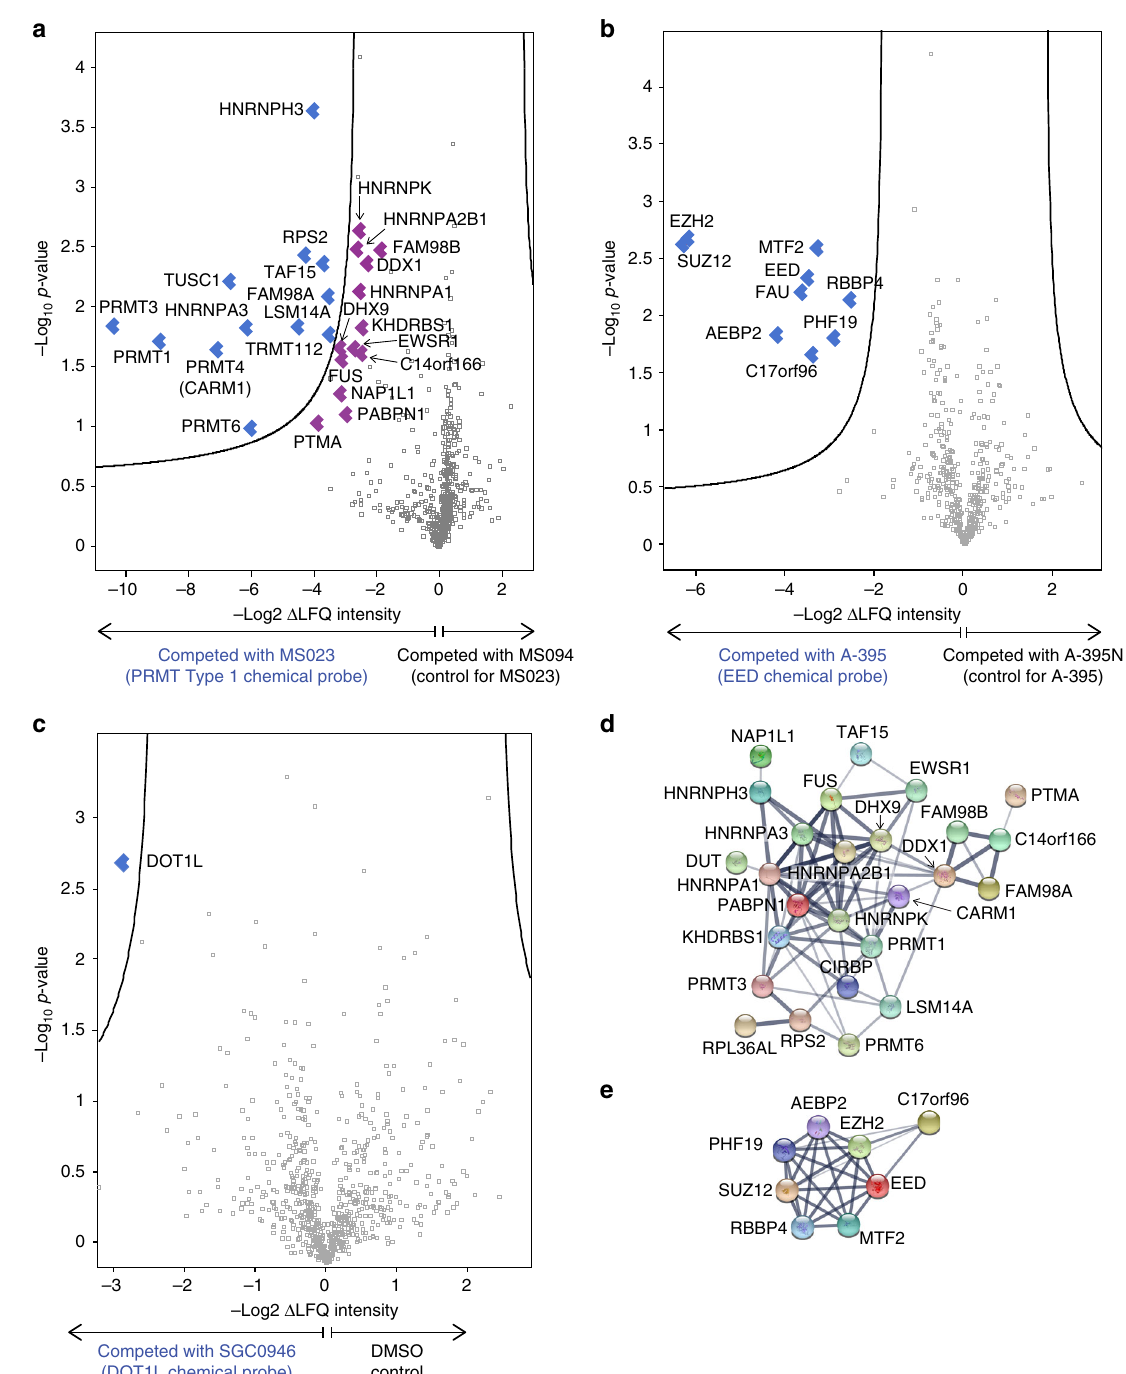
Fig. 3 Af fi nity Reagents for Chemoproteomics. a Volcano plot of MTM7172-enriched proteome (labeled blue) from HEK293 cell lysate, with targets signi fi cantly (FDR = 0.05, S0 = 0.2) competed by 20 μ M MS023 with respect to 20 μ M MS094 negative control. Proteins marked in purple indicate known interactors of the identi fi ed direct targets of MS023 close to the signi fi cance threshold. b Volcano plot of (A-395)-NH 2 -enriched proteome (labeled blue) from G401 cell lysate, with targets signi fi cantly (FDR = 0.05, S0 = 0.2) competed by 20 μ M A-395 with respect to 20 μ M A-395N negative control. c Volcano plot of SGC2077-enriched proteome (labeled blue) from Jurkat cell lysate, with targets signi fi cantly (FDR = 0.05, S0 = 0.2) competed by 20 µ M SGC0946, with respect to DMSO control. d STRING network evaluation of targets signi fi cantly competed by MS023. Lines in the STRING evaluation represent evidenced interactions, with line thickness indicating con fi dence (high to low). e STRING network evaluation of targets signi fi cantly competed by A-395. The chemical structures of the chemical biology reagents, MTM7172, (A-395)-NH 2 , and SGC2077, are shown in Supplementary Table 2. See